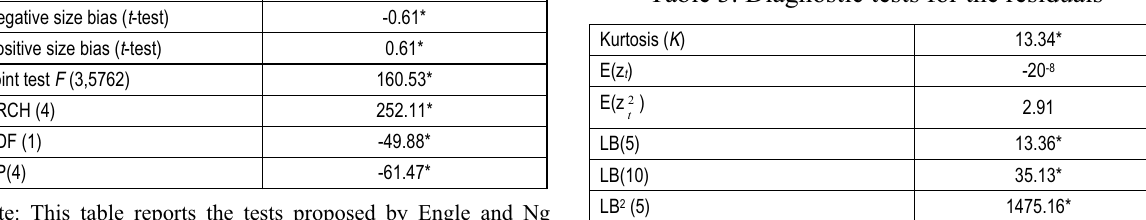
Table 3. Diagnostic tests for the